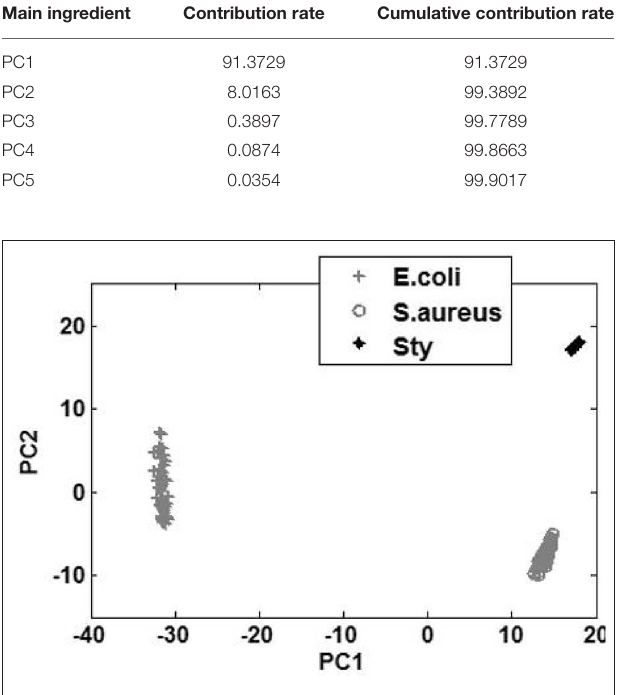
FIGURE 2 | Discrimination of the spectra of the three kinds of bacteria by